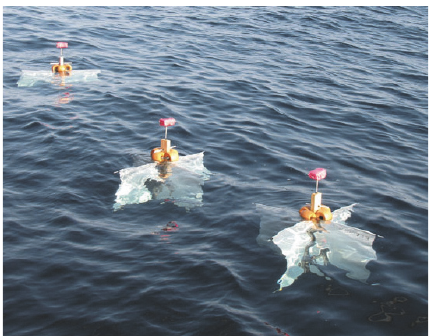
Figure 1: Surface drifters